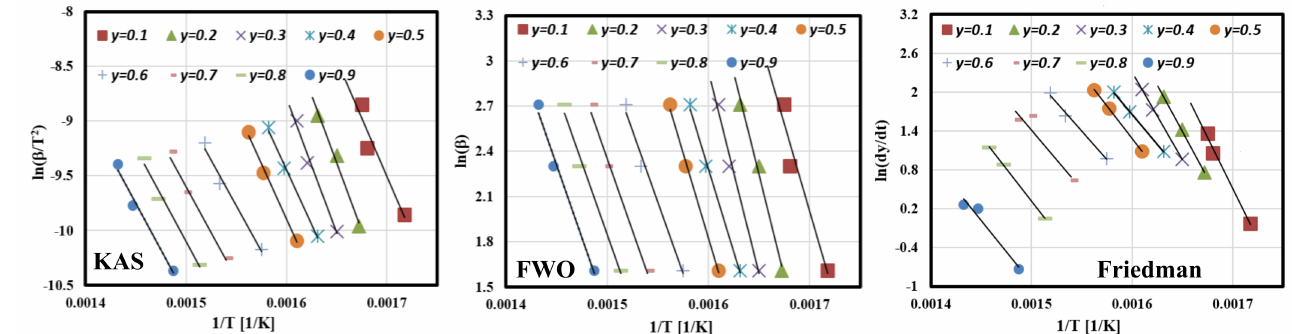
Figure 6. Plots of isoconversional methods at different values of conversion.